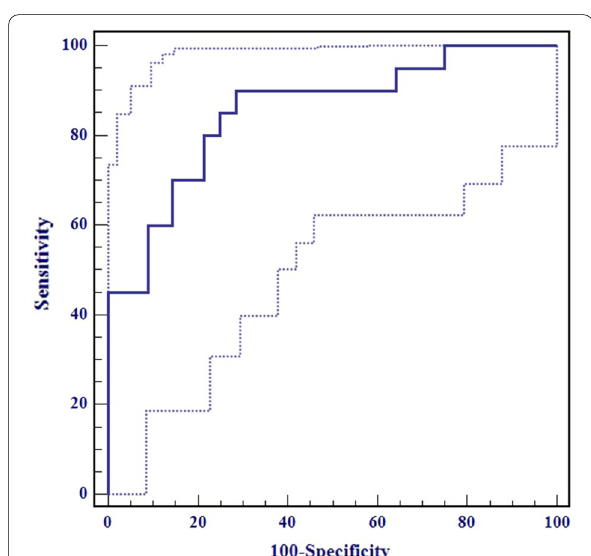
Fig. 5 Receiver operating characteristics (ROC) curve of the T2 value for predicting nodal staging of preoperatively node‑negative rectal cancer with the area under the ROC, sensitivity, specificity, and accuracy of 0.854, 90.0%, 71.4%, and 80.3%, respectively. The solid line represents the area under the ROC curve. The dotted line represents the 95% confidence